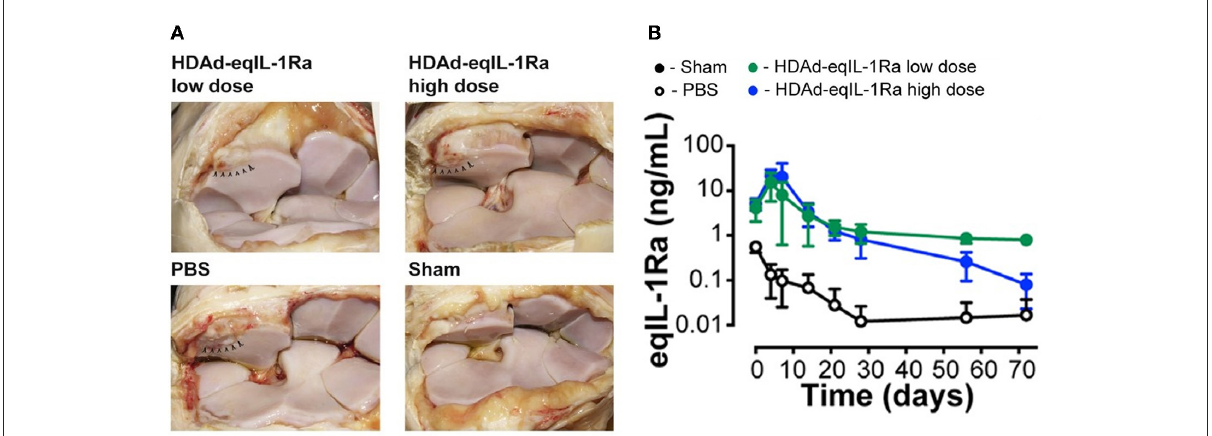
FIGURE1 (A) Synovial membrane of OA joints injected with helper-dependent adenoviral vector encoding equine IL-1Ra (HDAd-eqIL-1Ra) at a low dose (2 × 10 11 vp) or high dose (2 × 10 12 vp) were comparable to sham-operated joints, whereas PBS-treated control joints appeared more hemorrhagic. Arrowheads indicate the site of osteochondral fragmentation. (B) Equine IL-1Ra levels in the synovial fluid peaked at 4 days after injection and declined to 1 ng/ml and 0.1 ng/ml in the low- and high-dose HDAd-eqIL-1Ra groups towards the end of the study. Values are represented as mean ± SEM. Reproduced with permission from Nixon et al., 2018 (114).